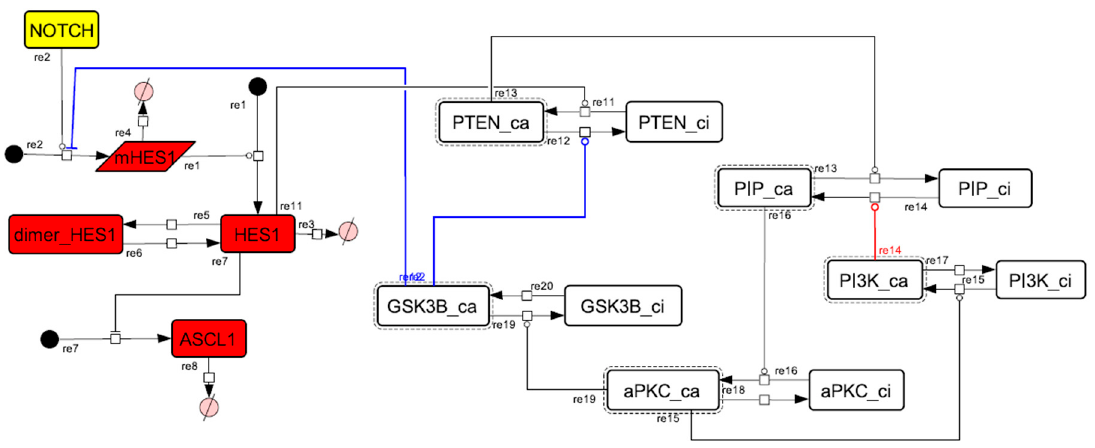
Figure A8. Diagram of the collapsed model of the HES1 self-feedback loop.